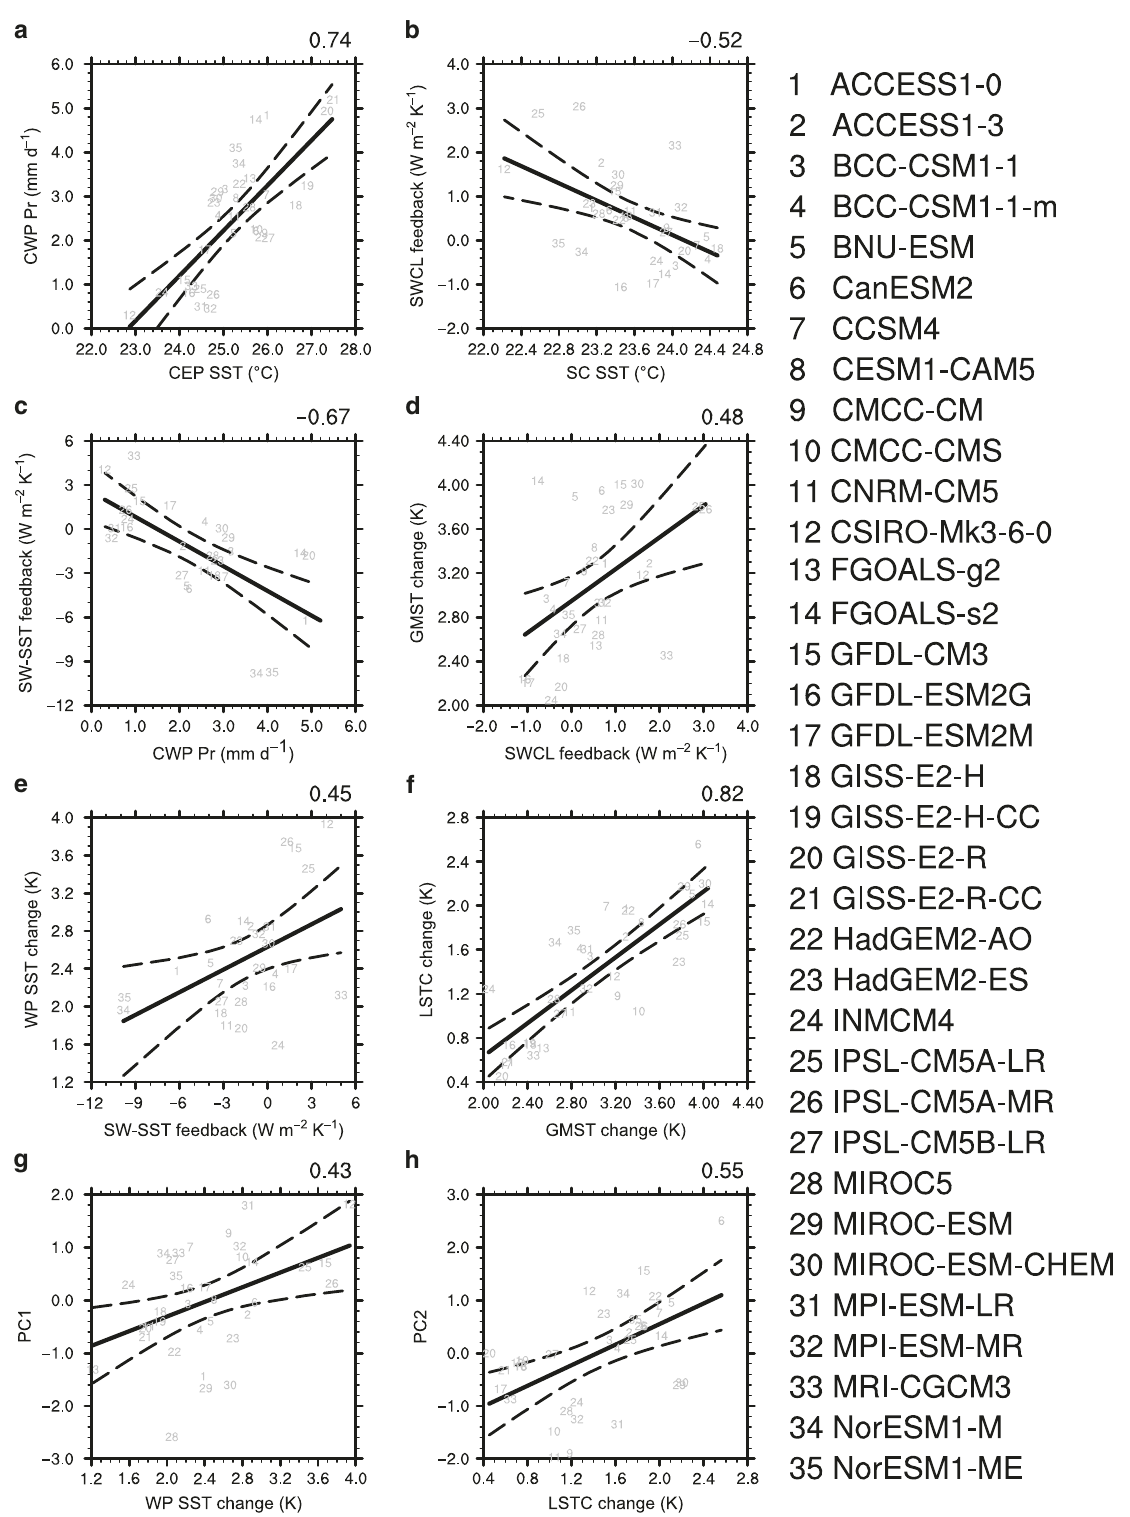
Fig. 6 Pipelining physical links between historical and projected spreads. a , c , e , g Intermodel relationship among the central-eastern Paci fi c (CEP) sea surface temperature (SST), central-western Paci fi c (CWP) precipitation, cloud shortwave-SST (SW-SST) feedback, western Paci fi c (WP) SST change, and the fi rst principal component (PC1). b , d , f , h Intermodel relationship among SST beneath the marine stratocumulus (SC), shortwave cloud (SWCL) feedback, global mean surface air temperature (GMST) change, land – sea thermal contrast (LSTC) change, and the second principal component (PC2). The indices above are de fi ned in “ Methods ” . Solid fi tting line is obtained by the least square method. Dashed curves denote the 95% con fi dence range of the linear regression. Value on the top-right corner of each subplot is correlation coef fi cient. All the correlation coef fi cients are statistically signi fi cant at the 5% level under Student t